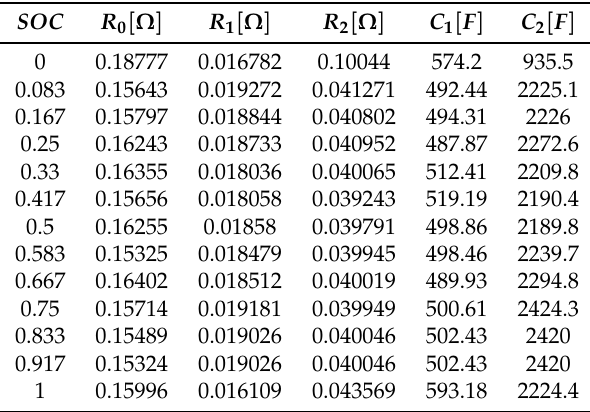
Table 1. Parameters of the second-order RC